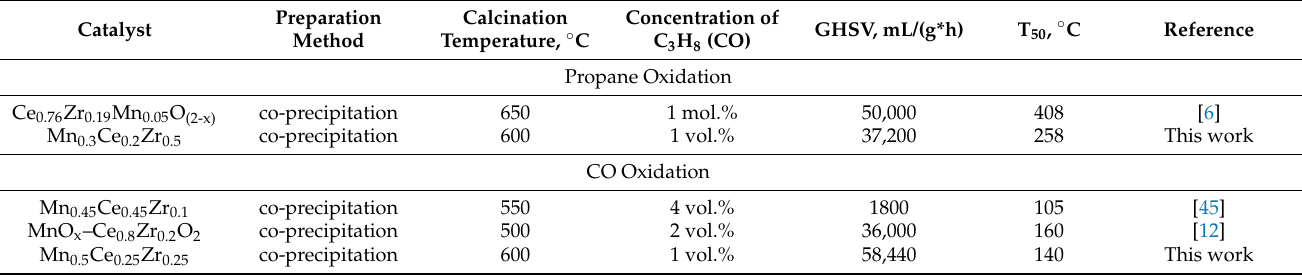
Table 5. Conversion of propane and CO on oxide ternary Mn-Zr-Ce catalysts reported in recent